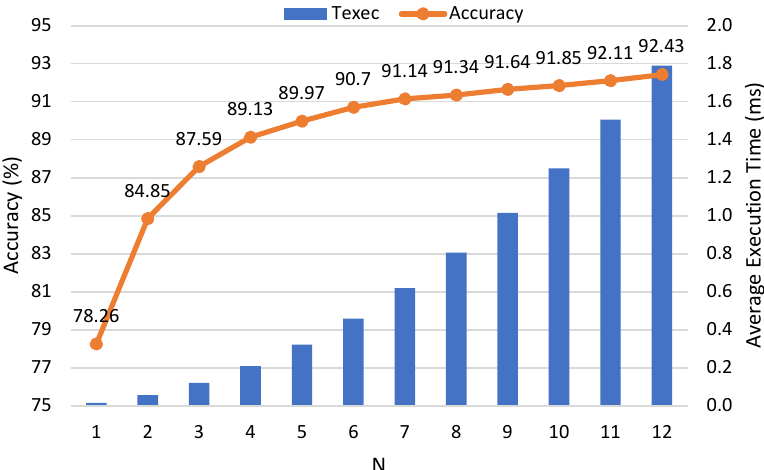
Figure 7. Average execution time of the inference of the proposed model for a variable number of filters with the CIFAR-10 dataset on a